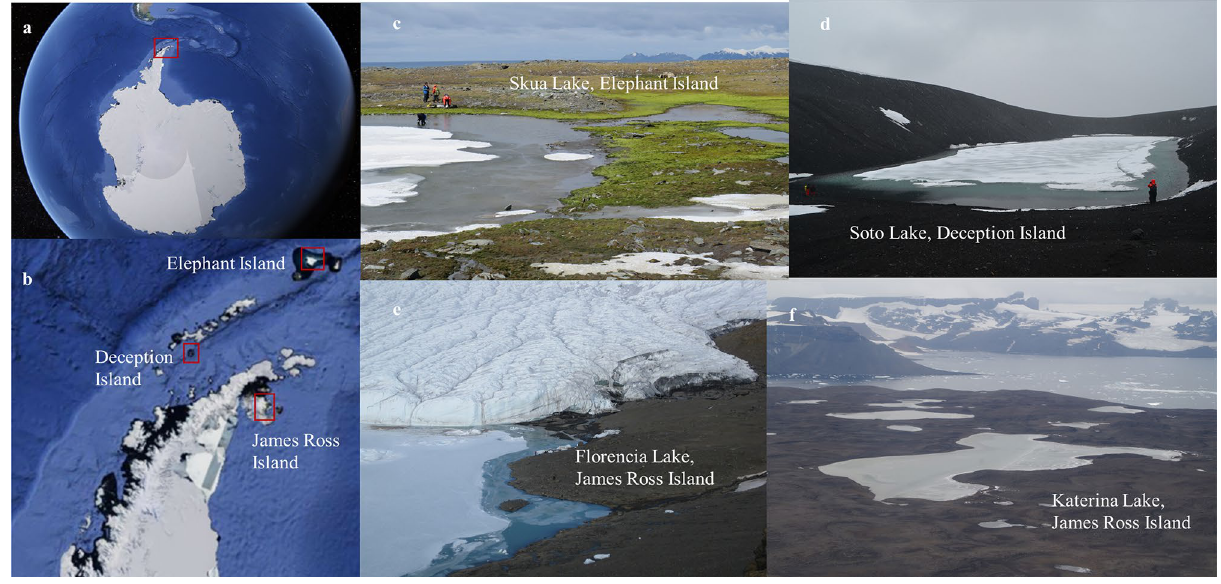
Figure 1. Satellite images ( a) and ( b) (obtained in Google Earth Pro, 2019). ( a ) Antarctica with the Antarctic Peninsula inside the red rectangle, ( b ) Elephant, Deception and James Ross Islands inside the red rectangle, ( c ) Skua Lake, Elephant Island (61°13 ′ 18.2 ″ S; 55°21 ′ 54.3 ″ W), ( d ) Soto Lake, Deception Island (62°58 ′ 44.6’’ S; 60°33 ′ 20.2’’ W), ( e ) Florencia (64°01 ′ 27.8’’ S; 57°40 ′ 00.6’’ W) and ( f ) Katerina Lakes (64°01 ′ 18.6’’ S; 57°43 ′ 26.2’’ W), James Ross Island. Photos ( c) and ( e) taken by Juan M. Lirio, photo ( f) taken by Matej Roman and photo ( d ) taken by Luiz H.